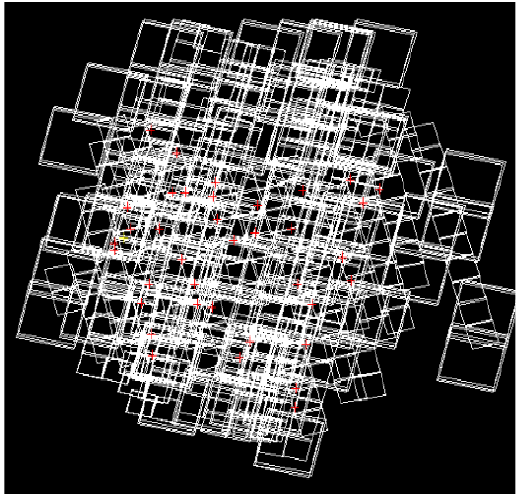
Figure 4. Distribution of experimental images and checkpoint (red cross is checkpoint